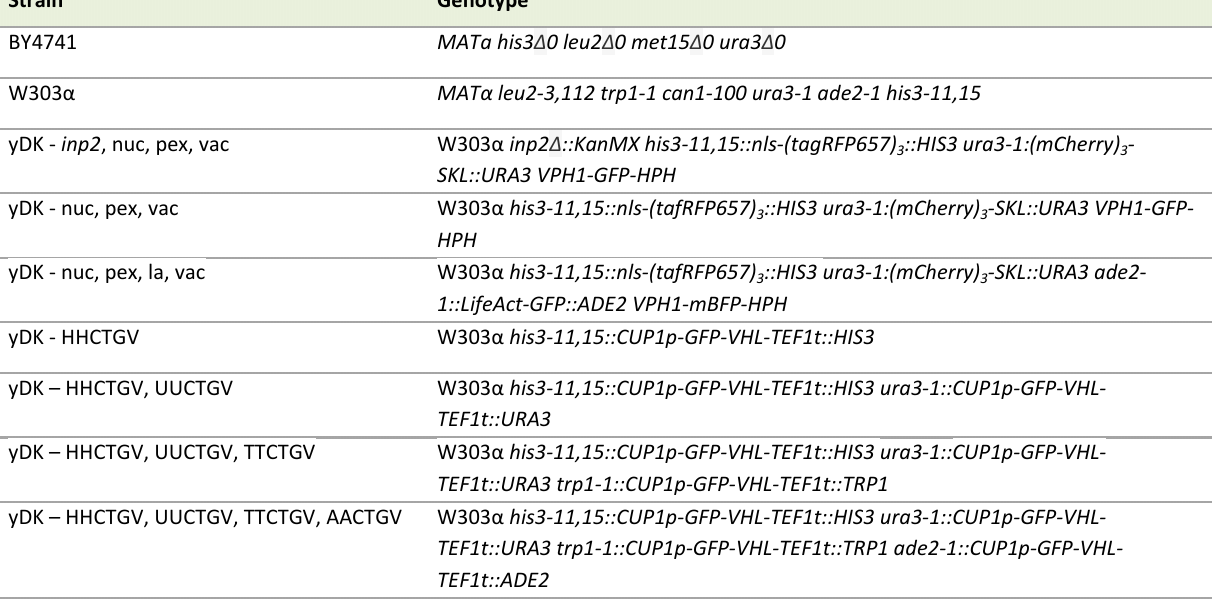
TABLE 2. Strains used in this study. Strain